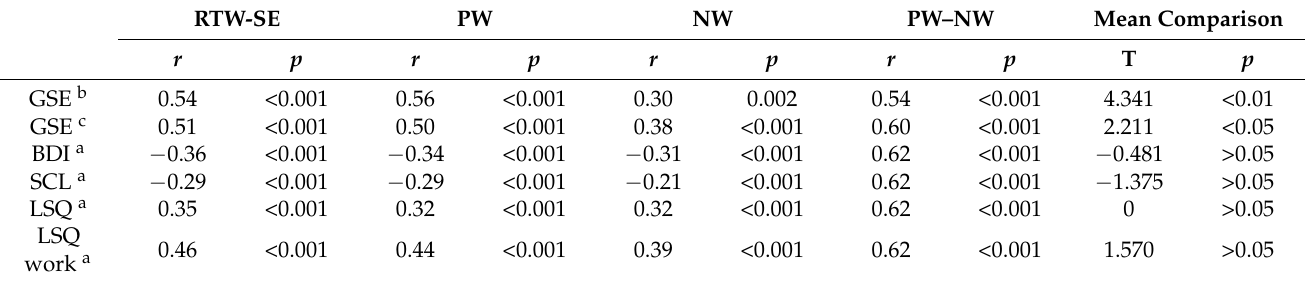
Table 3. Correlation coefficients for associations between (1) baseline RTW-SE, (2) PW, and (3) NW subscales and cognitive and disease-related